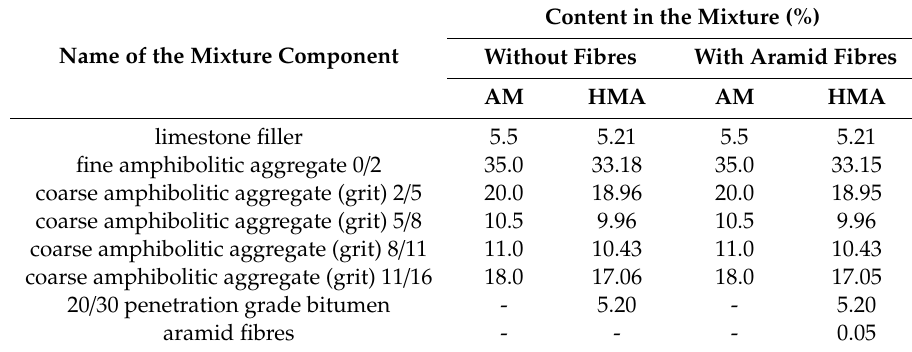
Table 2. Content of components of the HMAC 16B mixture with and without aramid fibres.